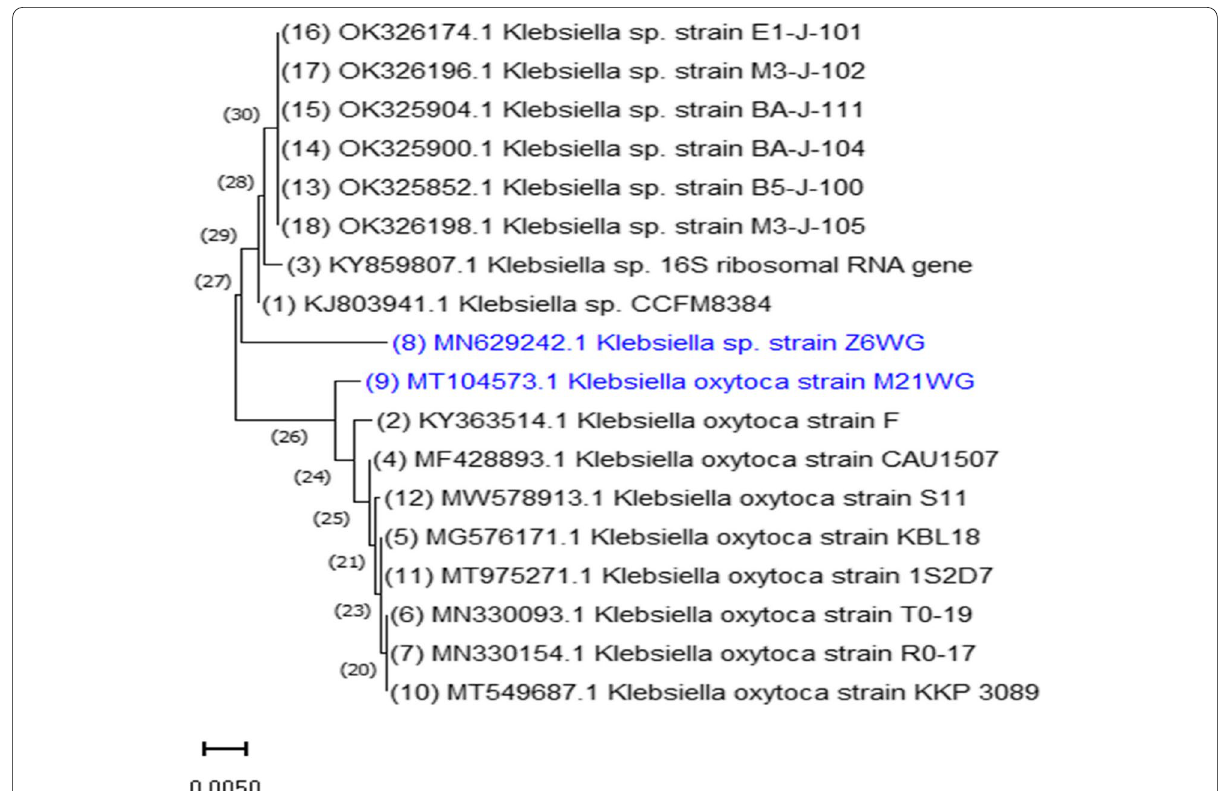
Fig. 3 Phylogenetic tree for the two bacterial isolates, Klebsiella oxytoca (M21WG) and Klebsiella sp.